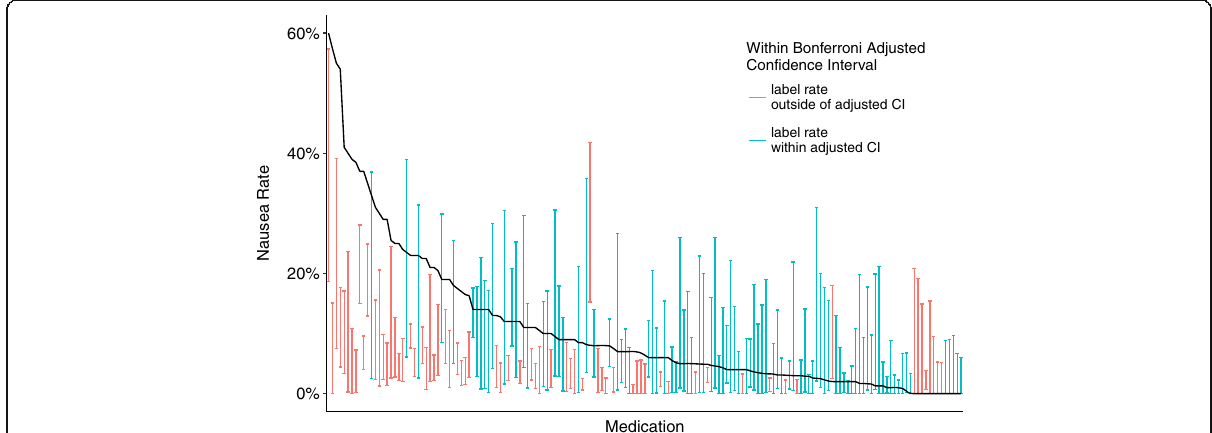
Fig. 4 Bonferroni-adjusted confidence internals for PLM nausea rates versus medication label nausea rates. For each generic treatment, PLM nausea rates and their associated 95% Bonferroni-adjusted confidence intervals are positioned along the horizontal axis, and medication label nausea rates are shown as a black line. In cases where the medication label nausea rate falls outside of the associated 95% confidence interval based on PLM data, treatments are colored red, identifying instances in which drug label nausea rates and PLM nausea rates were identified as having notable differences, after accounting for multiple comparisons. Since not all drug labels reported the number of patients included in the associated study, it was not possible to assess the statistical significance of the differences between PLM and label nausea rates for each drug